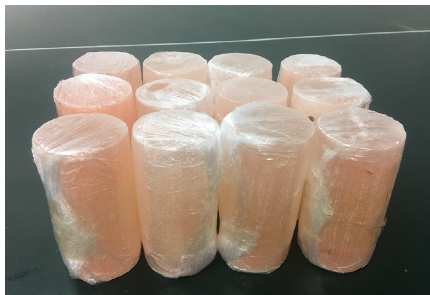
Figure 1: Rock salt samples.